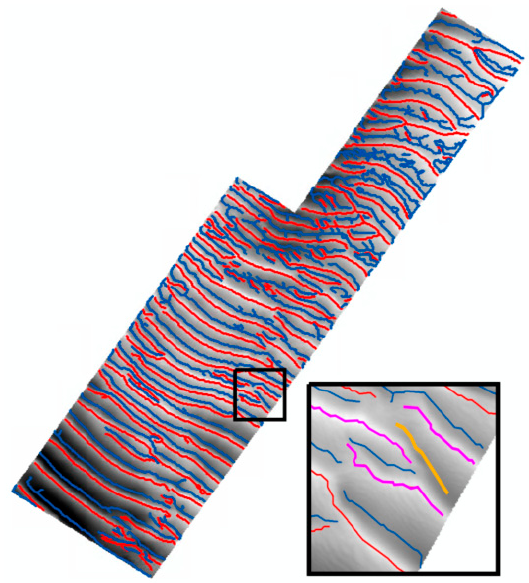
Figure 3. Example of the crest lines (red) and troughs (blue) of a field of dunes identified from a DBM. In the magnified view (i.e., black frame), we can observe that one trough (yellow) can be related to more than one dune (identified with the magenta crest lines).